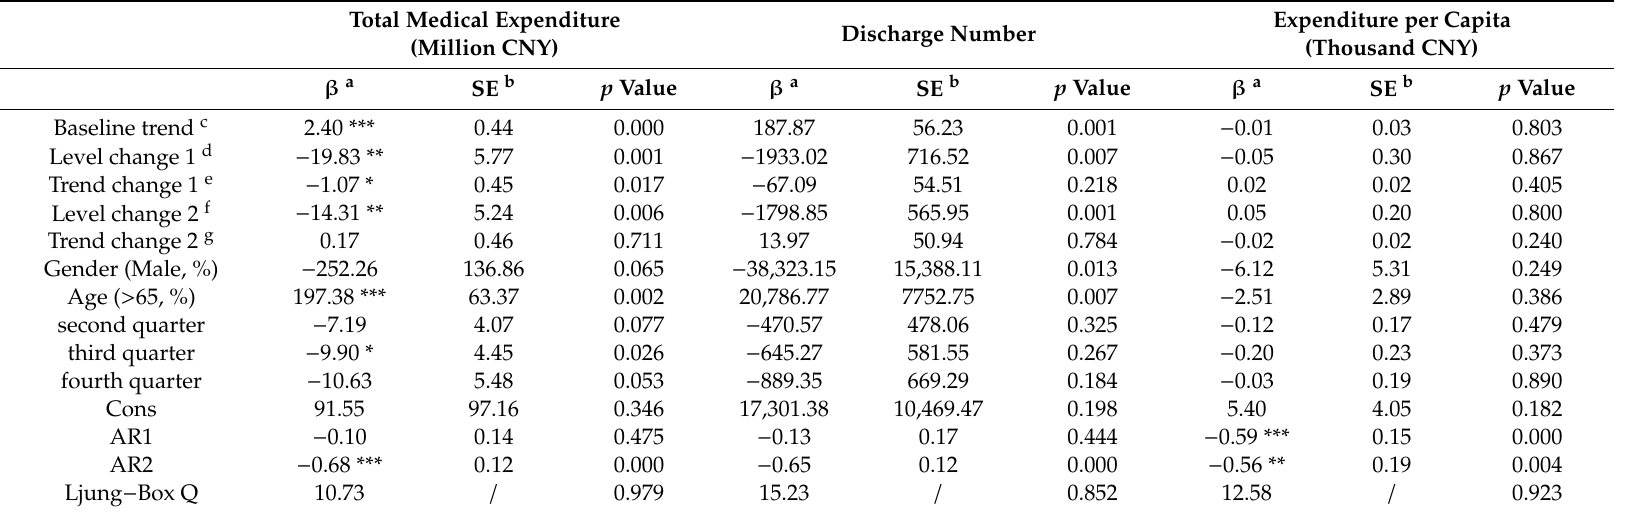
Table A1. Segmented autoregressive integrated moving average analysis of medical expenditure of respiratory